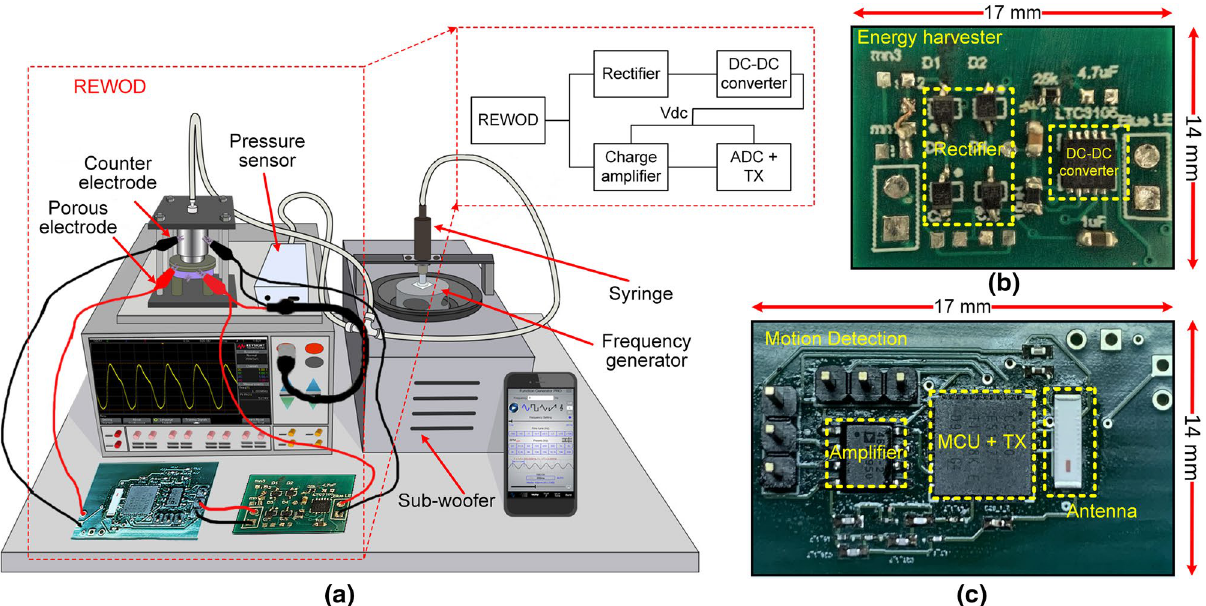
Figure 6. ( a ) Experimental setup for the REWOD energy harvester measurements, ( b ) fabricated PCB board of Energy harvesting circuitry, ( c ) fabricated PCB board of motion detecting circuitry.